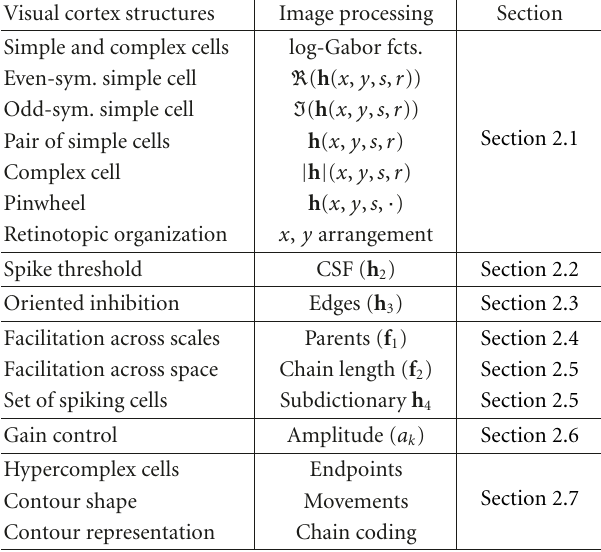
Table 1: Correspondences between visual cortex physiology and image processing operations defined in the di ff erent